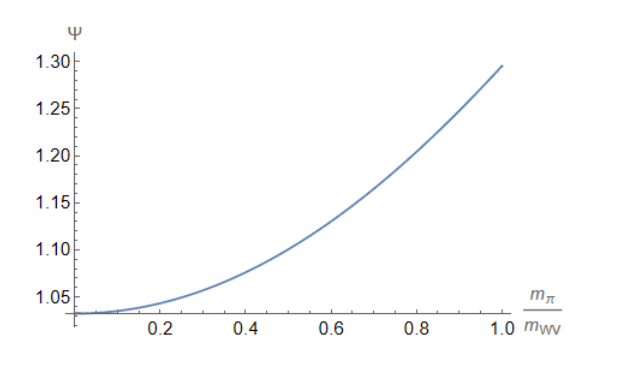
Figure 3 . The function Ψ( m π /m WV ) providing the quark-mass dependence of the soft part of the tension of the sheet.